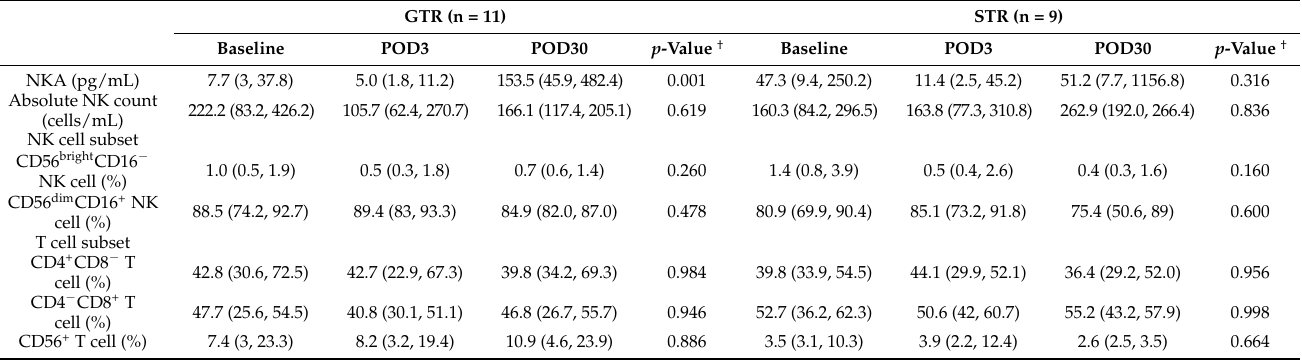
Table 3. NKA and NK cells in glioblastoma patients before and after GTR and STR.